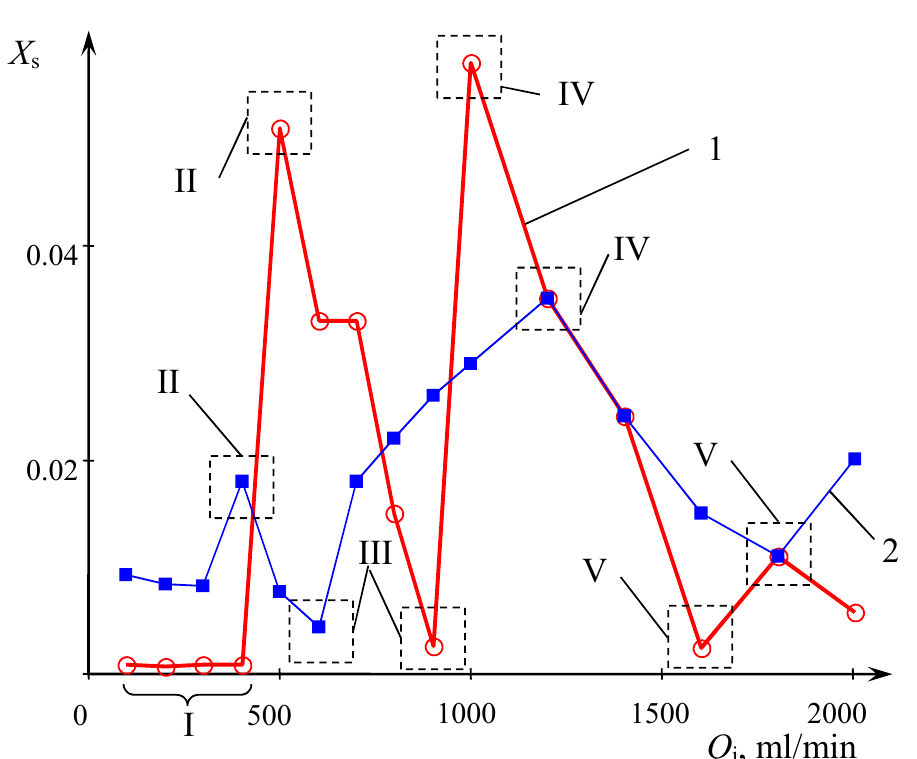
Figure 4. The results of an iodide-iodate technique—the dependence of the segregation coefficient X s in the solution at the outlet of MRFIJ (2θ = 107°, d j = 1.0 mm, T = 21 °C) on the pump flow rate Q 1 = Q 2 . 1-distilled water; 2-deionized water. I-V–characteristic zones of triiodide concentration variations.